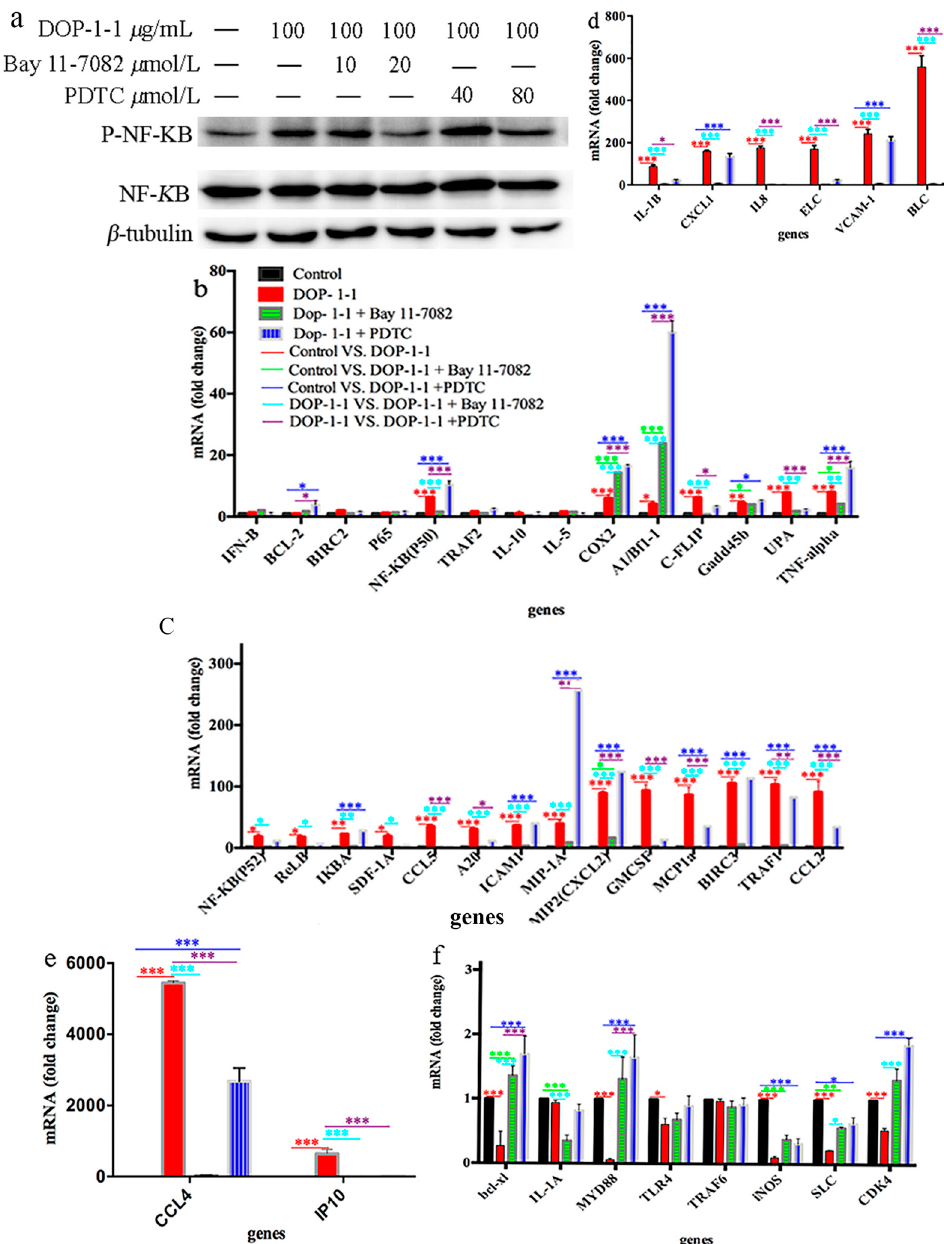
Figure 6. Comparison of the expression profile of genes associated with NF- κ B between DOP-1-1treated cells and untreated cells. ( a ) The effects of PDTC and bay 11-7082 (NF- κ B inhibitor) on NF- κ B ( b ) mRNA fold changing ranged from 1 to 10; ( c ) mRNA fold changing ranged from 10 to 150; ( d ) mRNA fold changing ranged from 150 to 1000; ( e ) mRNA fold changing ranged from 2000 to 6000. ( f ) DOP-1-1 down-regulated genes; (Each assay was performed in triplicate. * p < 0.05, ** p < 0.01, *** p < 0.001).